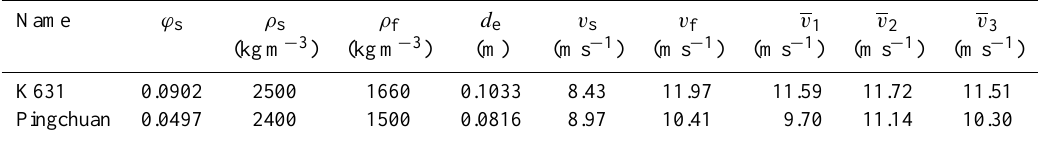
Table 1. The results of velocity calculation for the K631 (G217 highway) and Pingchuan debris flows.